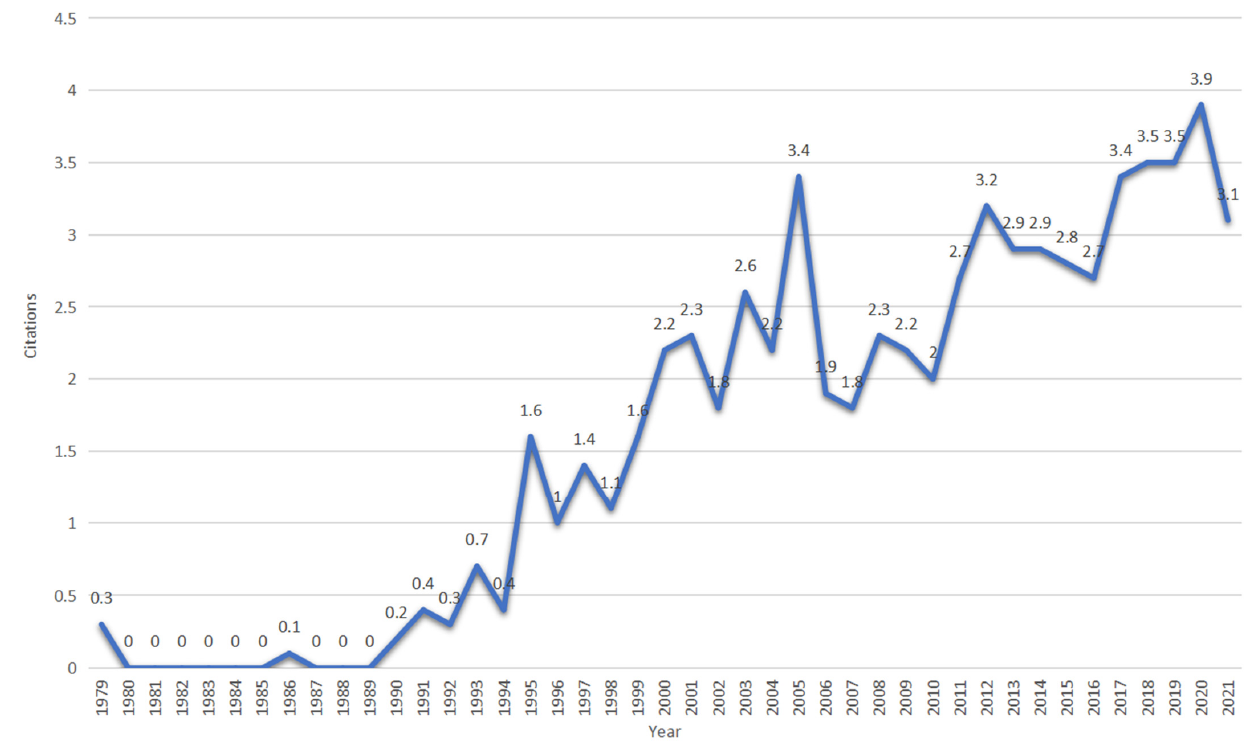
Figure 3. Annual citations of papers published by Web of Science from 1979 to 2021.